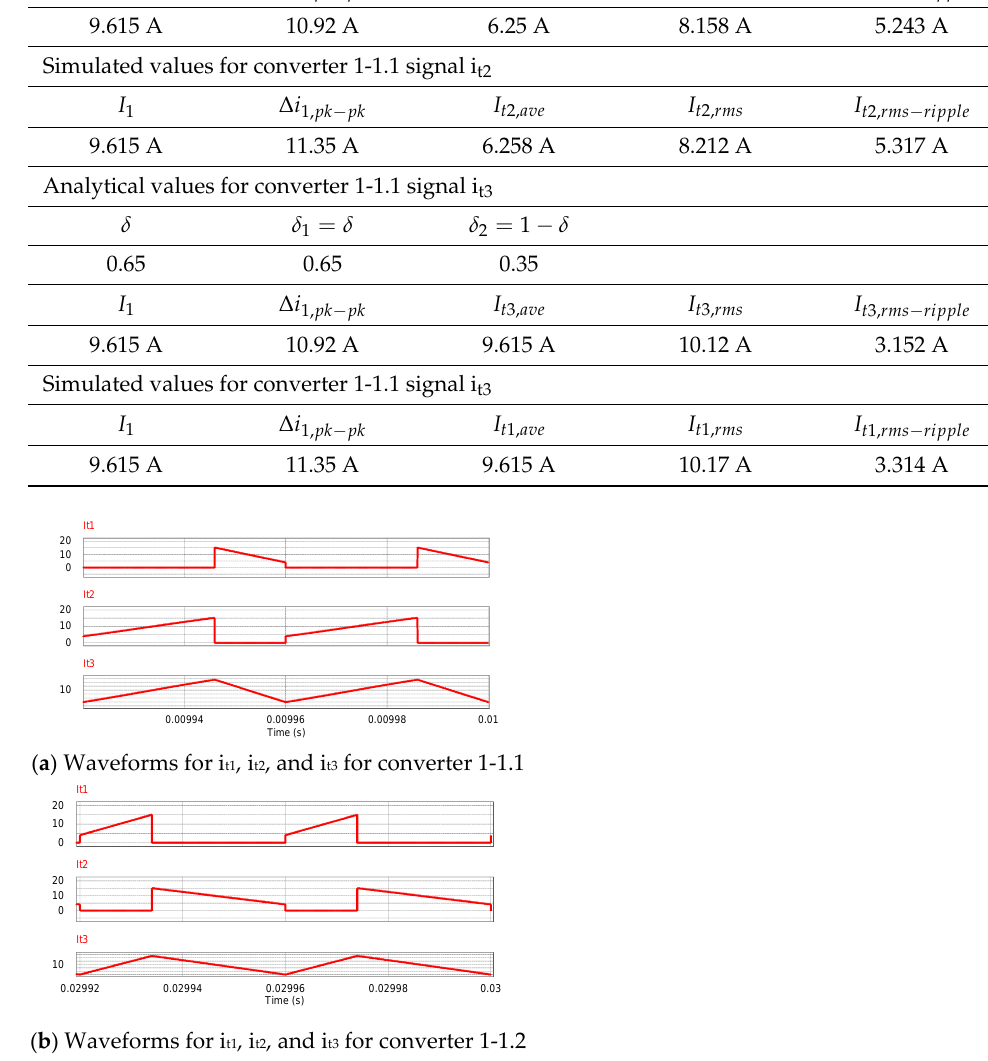
Figure 14. Current waveforms for converters 1-1.1 and 1-1.2 during CCM . Table 1. Analytical and simulated data for converter 1-1.1 when in CCM.